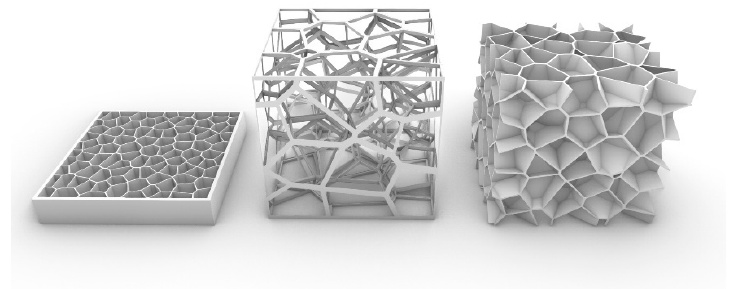
Figure 6. Voronoi classification: 2.5D Voronoi (left); open 3D Voronoi (middle); and closed 3D Voronoi (right).